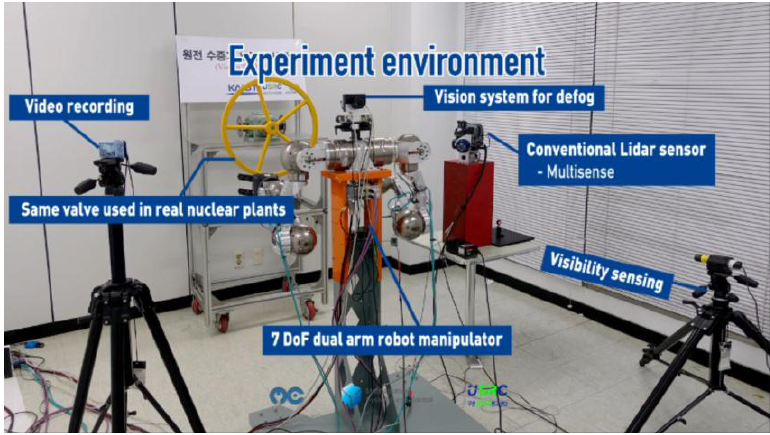
Figure 10. Experiment environment of valve turning manipulation in foggy condition.